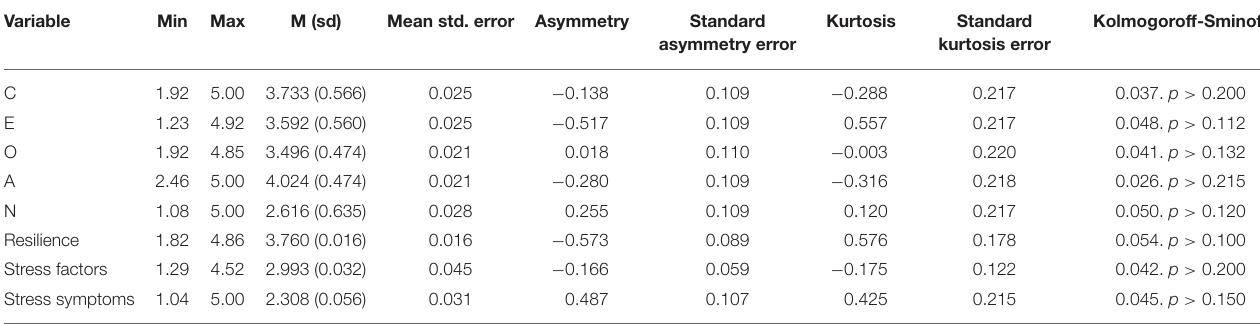
TABLE 1 | Descriptive values of the study variables ( n = 405).